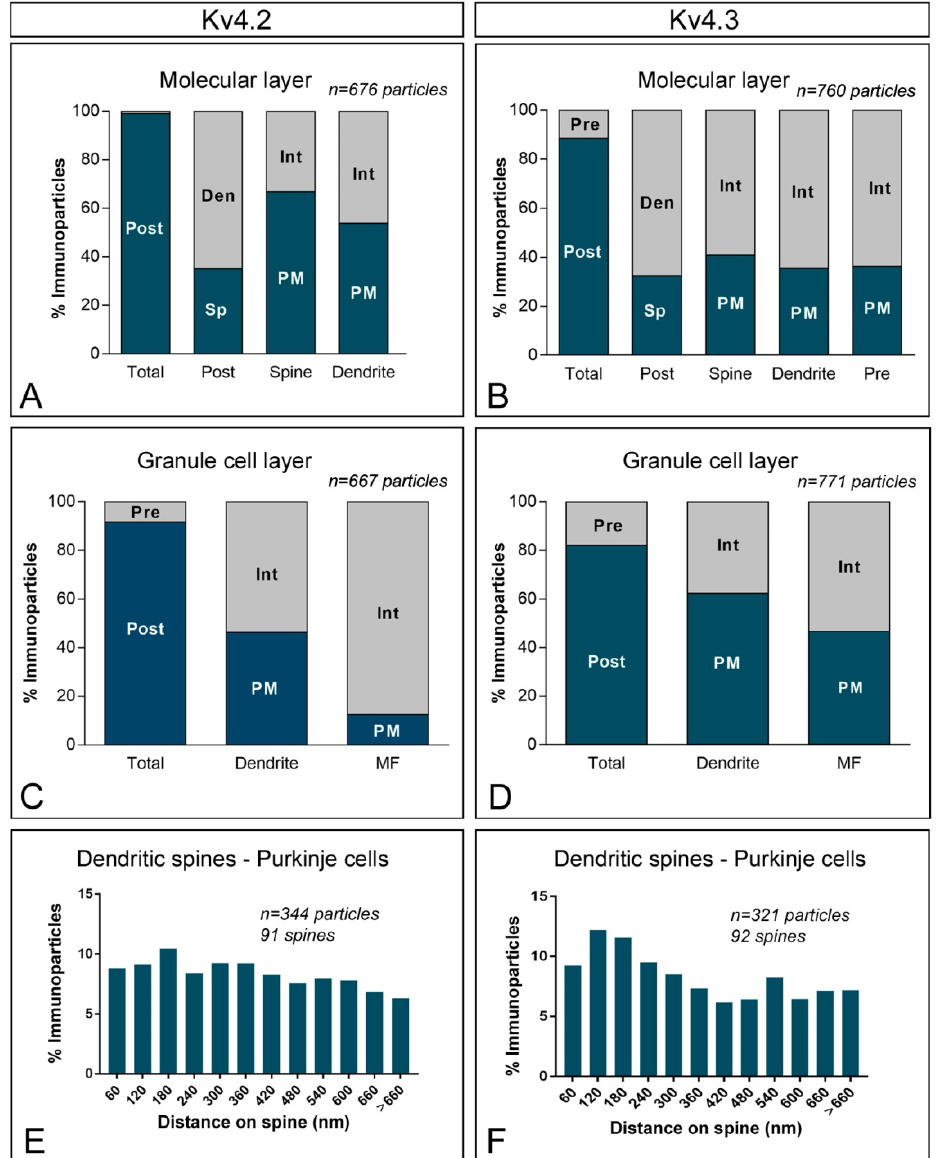
Figure 8. Compartmentalisation of voltage-gated potassium (Kv) channel subunits Kv4.2 and Kv4.3 in cerebellar cells. ( A , B ) Bar graphs showing the percentage of immunoparticles for Kv4.2 and Kv4.3 in neuronal compartment in the molecular layer. Immunoparticles for Kv4.2 were mostly localised at the postsynaptic compartment (99% of all particles), while Kv4.3 was distributed at postsynaptic (88.4%) and presynaptic (11.6%) compartments. ( C , D ) Bar graphs showing the percentage of immunoparticles for Kv4.2 and Kv4.3 in the neuronal compartment in the granule cell layer. A total of 667 immunoparticles for Kv4.2 and 771 for Kv4.3 were analysed. Postsynaptically, immunoparticles were detected in dendrites of GCs (91.6% for Kv4.2; 82.2% for Kv4.3), distributed along the plasma membrane (46.3% for Kv4.2; 62.3% for Kv4.3) and at cytoplasmic sites (53.7% for Kv4.2; 37.7% for Kv4.3). Presynaptically, immunoparticles were detected in mossy fibre terminals (8.4% for Kv4.2; 17.8% for Kv4.3), distributed at cytoplasmic sites (87.5% for Kv4.2; 53.3% for Kv4.3) and along the plasma membrane (12.5% for Kv4.2; 46.7% for Kv4.3). ( E , F ) Histogram showing the distribution of immunoparticles for Kv4.2 and Kv4.3 in relation to glutamate release sites in dendritic spines of PCs. About 46% of immunolabelled Kv4.2 and 52% of immunolabelled Kv4.3 were located in a 60–300 nm wide band. These data show that Kv4.2 immunoparticles were more equally distributed along PC spines, while immunoparticles Kv4.3 were skewed toward the PSD of PC spines.